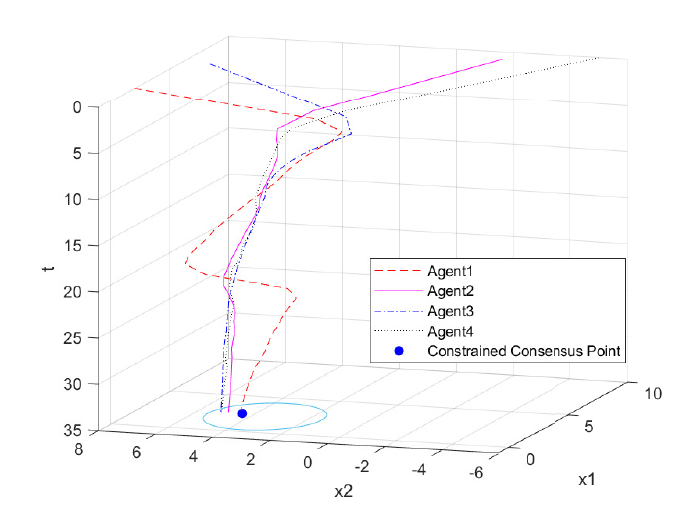
Figure 7. All state trajectories of agents in other method.